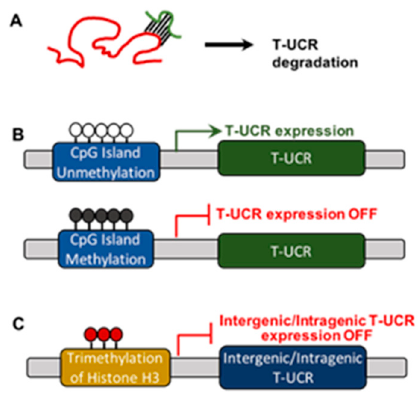
Figure 3. Regulation of T-UCR expression by ( A ) miR, ( B ) CpG island methylation, or ( C ) trimethylation of histone